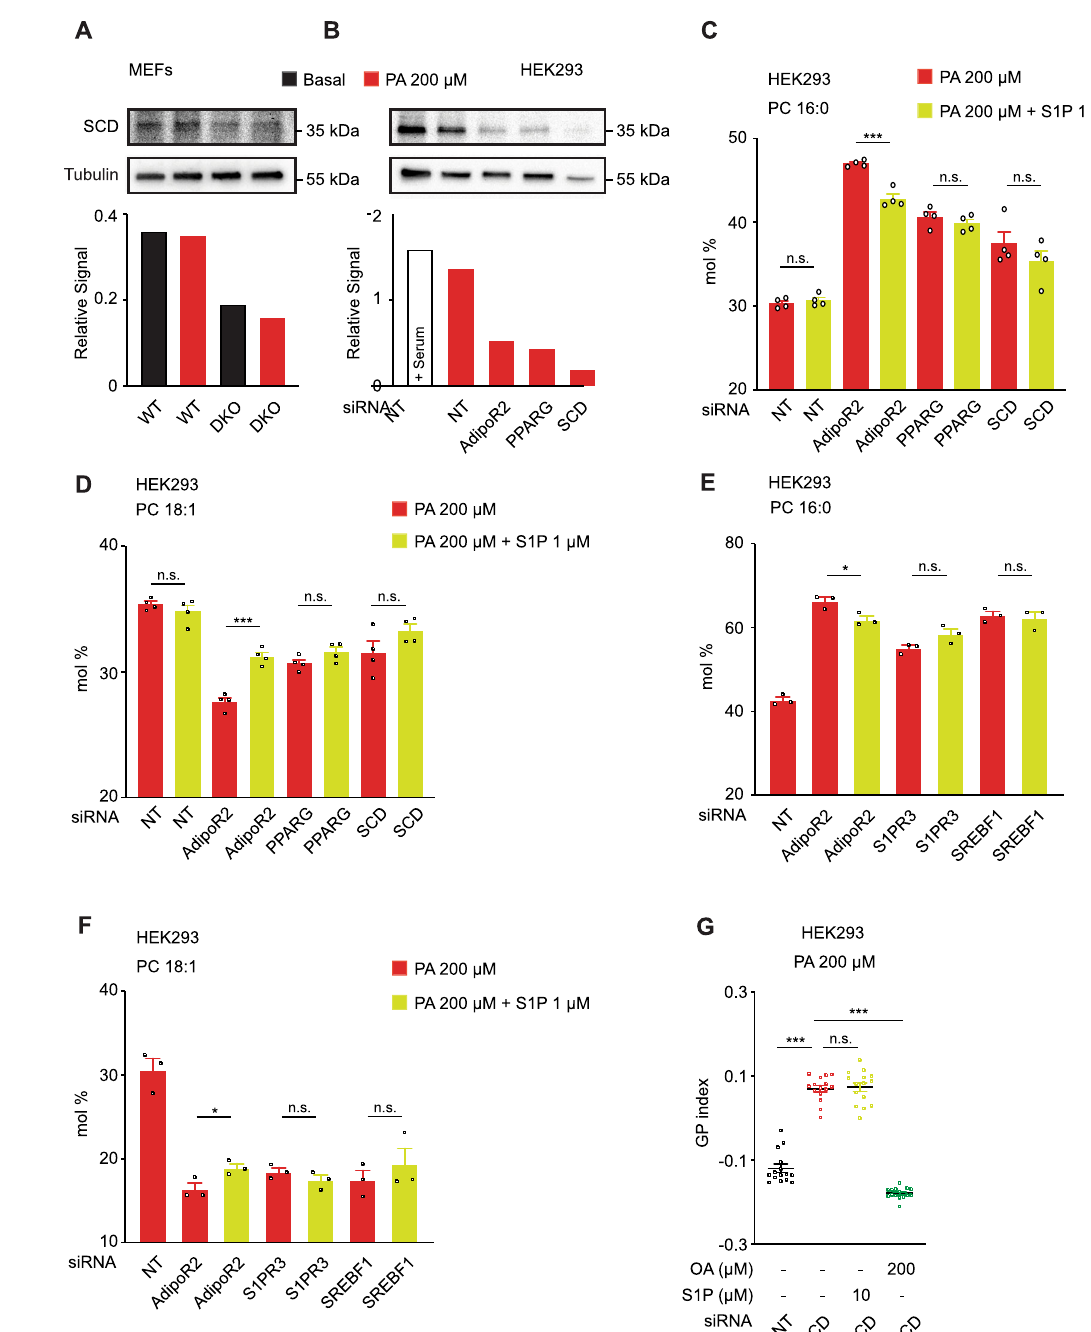
Fig. 6 | SCD is the fi nal protein effector of the AdipoR2-S1P pathway. A , B Western-Blot and quanti fi cation of WT and DKO MEFs in A and NT and Adi- poR2/PPAR γ /SCD siRNA in HEK293 cells in full media or basal media±PA 200 µ M. UncroppedblotsinSourceData. C – F PA(16:0)andOA(18:1)abundance(mol%)and in the PC of HEK293 cells treated with different siRNA and PA 200 μ M±S1P 1 μ M. ForCandD, n =4independentbiologicalreplicatespercondition.For E and F , n =3 independent biological replicates per condition. Related lipidomics are shown in